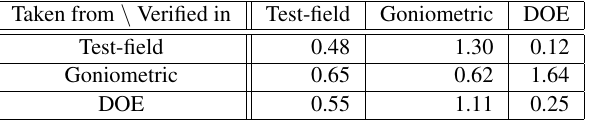
Table 3: RMS of image coordinate residuals from cross-method verification in pixel. Reduced distortion models